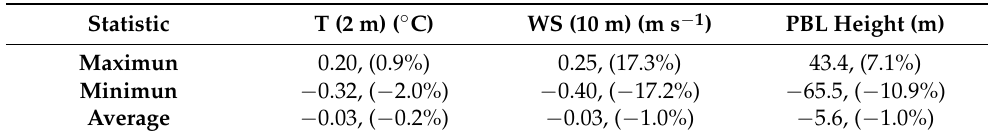
Table 2. Summary of the effect of the NBS on the main meteorological variables (relative change in